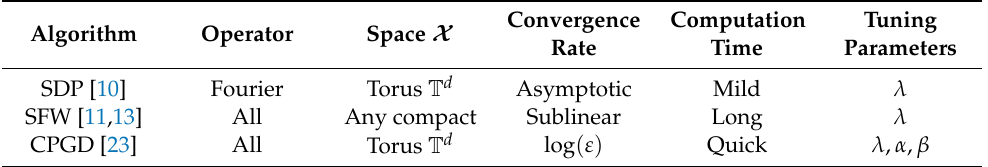
Table 1. Pros and cons for the different off-the-grid algorithm strategies, Semi-definite programming